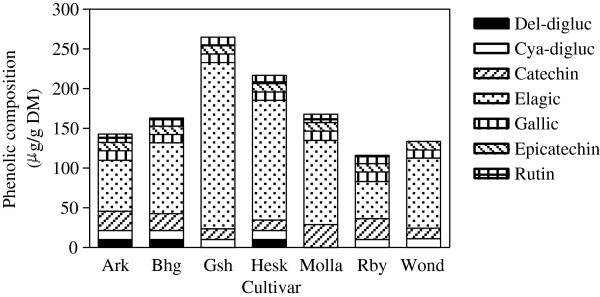
Phenolics composition in peel methanol extracts of seven pomegranate cultivars. Ark- Arakta, Bhg- Bhagwa, Gsh- Ganesh, Hesk- Herskawitz, Molla- Molla de Elche, Rby- Ruby & Wond- Wonderful.